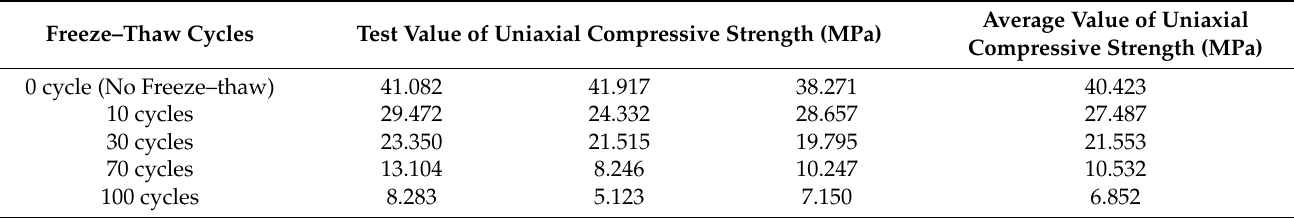
Figure 10. Uniaxial compressive strength of samples. Table 3. Uniaxial compressive strength of samples.